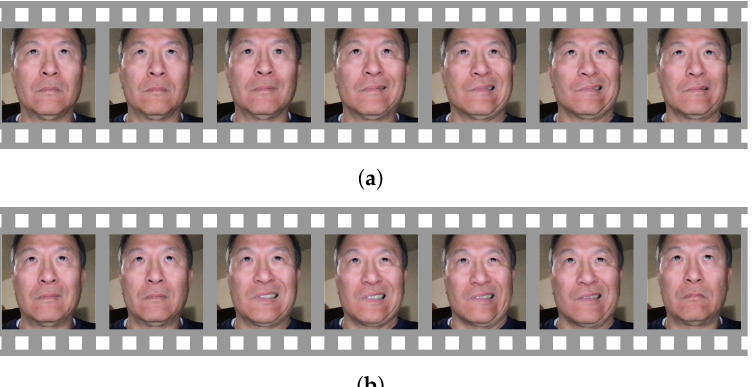
Figure 6. False negative example with different video ending. ( a ) ends at the peak of the facial motion. ( b ) ends at the neutral face.